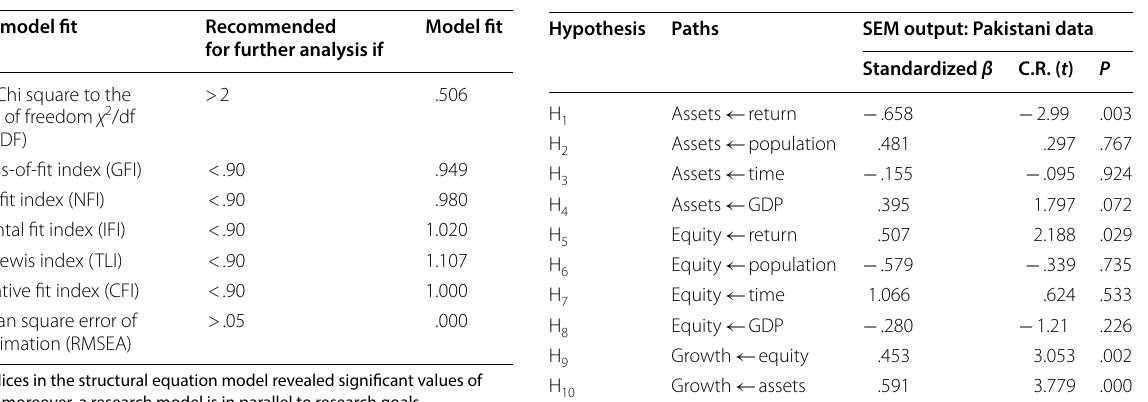
Table 6 Level of model fit for model Table 7 Results of